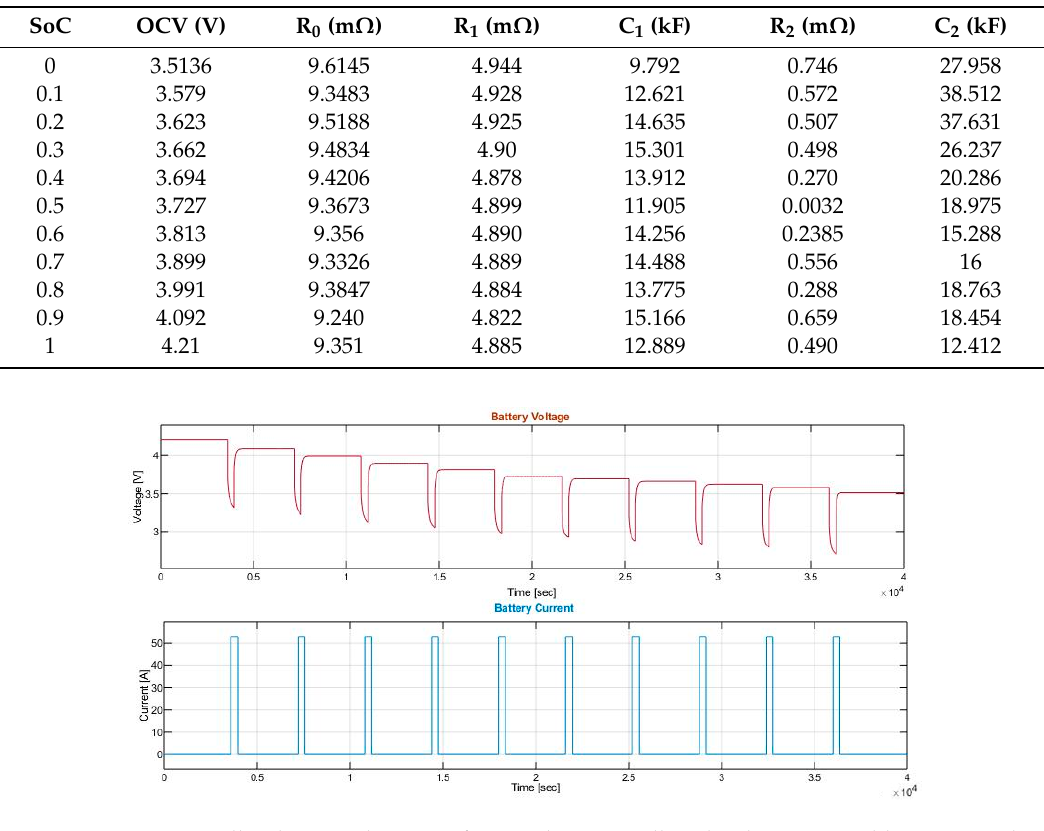
Figure 4. Battery cell voltage and current for 53 Ah NMC cell with 1h rest period between each SoC change.